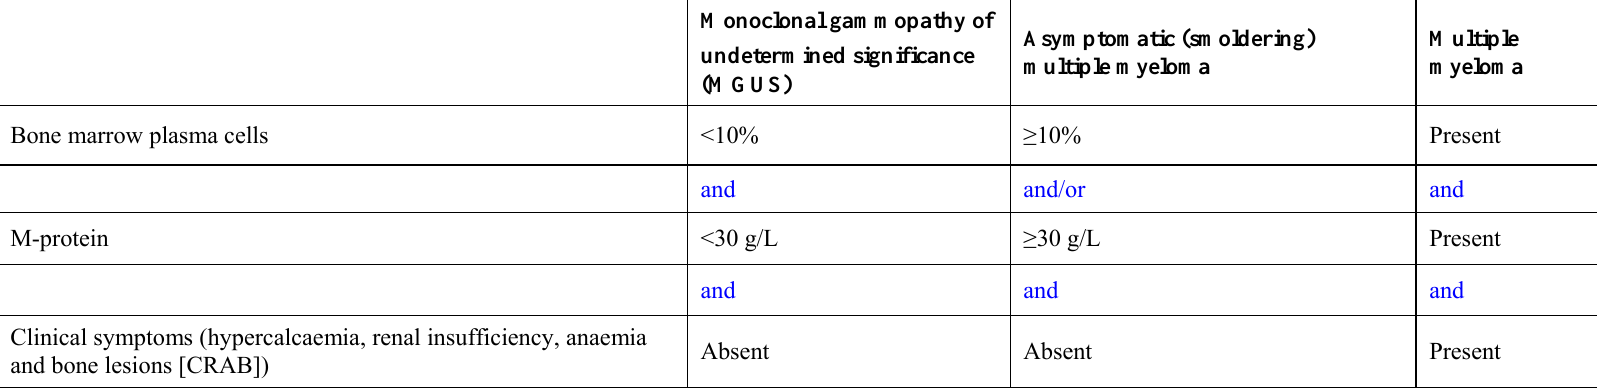
Table 1 Diagnostic criteria for monoclonal gammopathy of undetermined significance (MGUS), asymptomatic (smoldering) multiple myeloma and multiple myeloma [4,